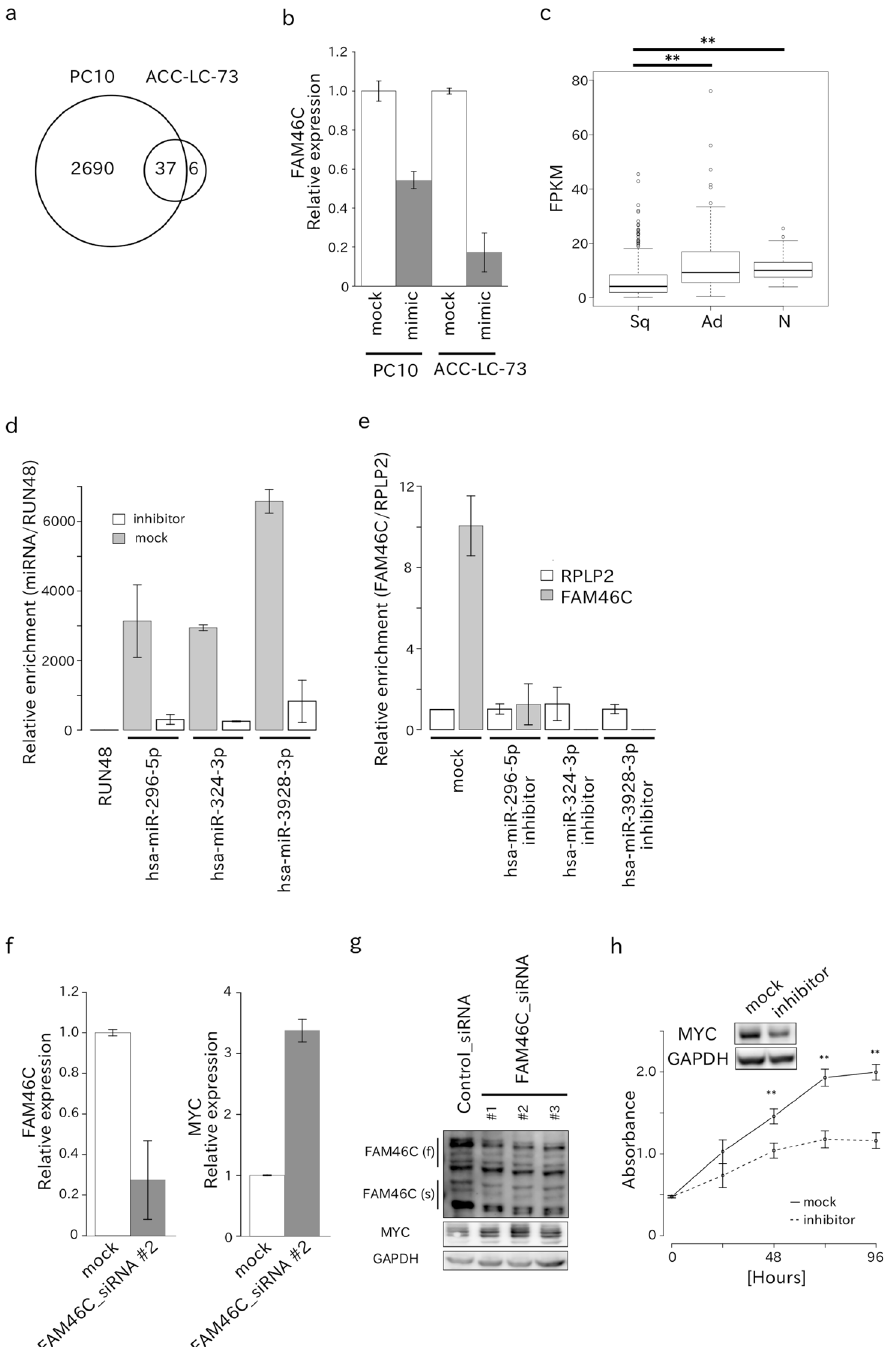
Figure 4. Target prediction and experimental validation. ( a ) Comparison of the common genes downregulated by miR-296-5p, miR-324-3p, and miR-3928-3p in PC10 or ACC-LC-73 cells. ( b ) Barplot demonstrating the ability of miRNA mimics to reduce FAM46C mRNA expression in PC10 or ACC-LC-73 cells. ( c ) Boxplot showing the decrease in FAM46C expression in Sq compared to Ad and normal tissues (N). P-values were calculated with the Wilcoxon rank sum test: ( ** ) P-value < 0.01. ( d ) Barplot showing the ability of each miRNA to bind to AGO2 protein. ( e ) Barplot showing the ability of FAM46C mRNA to bind to AGO2 protein via miRNA. ( f ) Barplot demonstrating the ability of FAM46C siRNA to inhibit FAM46C mRNA expression in PC10 cells ( left ). Barplot demonstrating the ability of FAM46C siRNA to enhance MYC mRNA expression in PC10 cells ( right ). Error bars show standard deviations. ( g ) Western blot showing the decrease in FAM46C protein (f: full-length protein, s: short-length protein, ref. 11 ) expression and the increase in MYC protein expression upon transfection with FAM46C siRNA. ( h ) Polygonal line demonstrating the ability of the combination of the three miRNA inhibitors to suppress the proliferation of PC10 cells. Western blot showing the decrease in MYC protein expression upon transfection of the combination of the three miRNA inhibitors miRNAs in PC10 cells (see also Supplementary Fig.